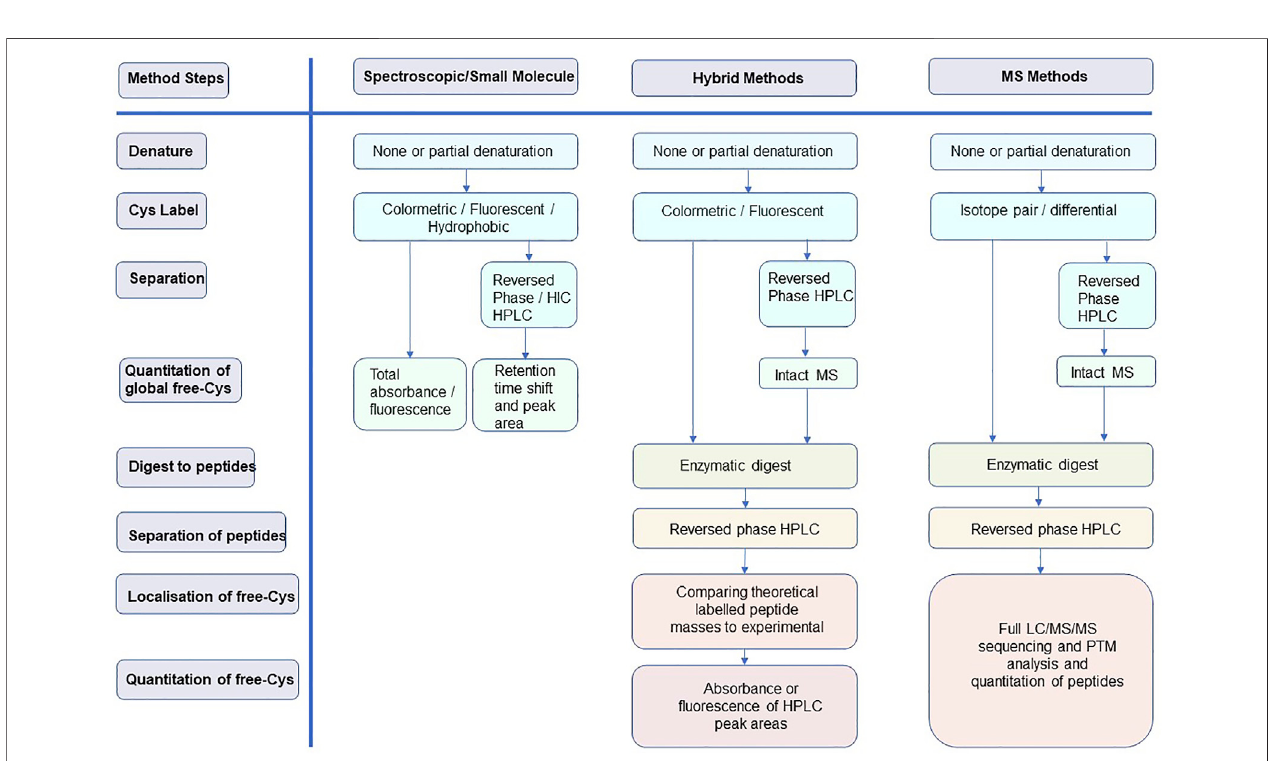
FIGURE 2 | Typical work fl ows for the three method classes discussed in this review highlighting how each of the method steps is addressed.